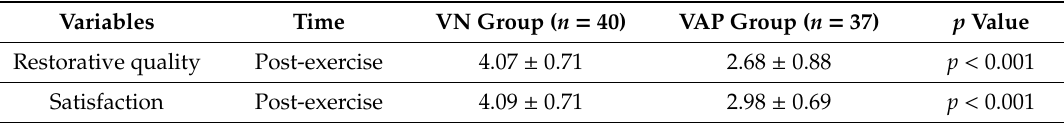
Table 3. Comparisons of restorative quality and satisfaction levels between the VN group and the VAP group.